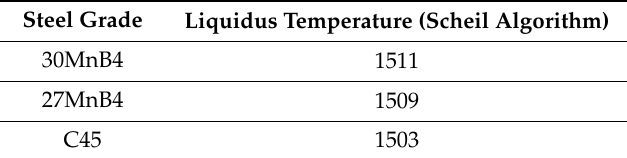
Table 3. Liquidus temperature values for the analyzed steel grades [ ◦ C].